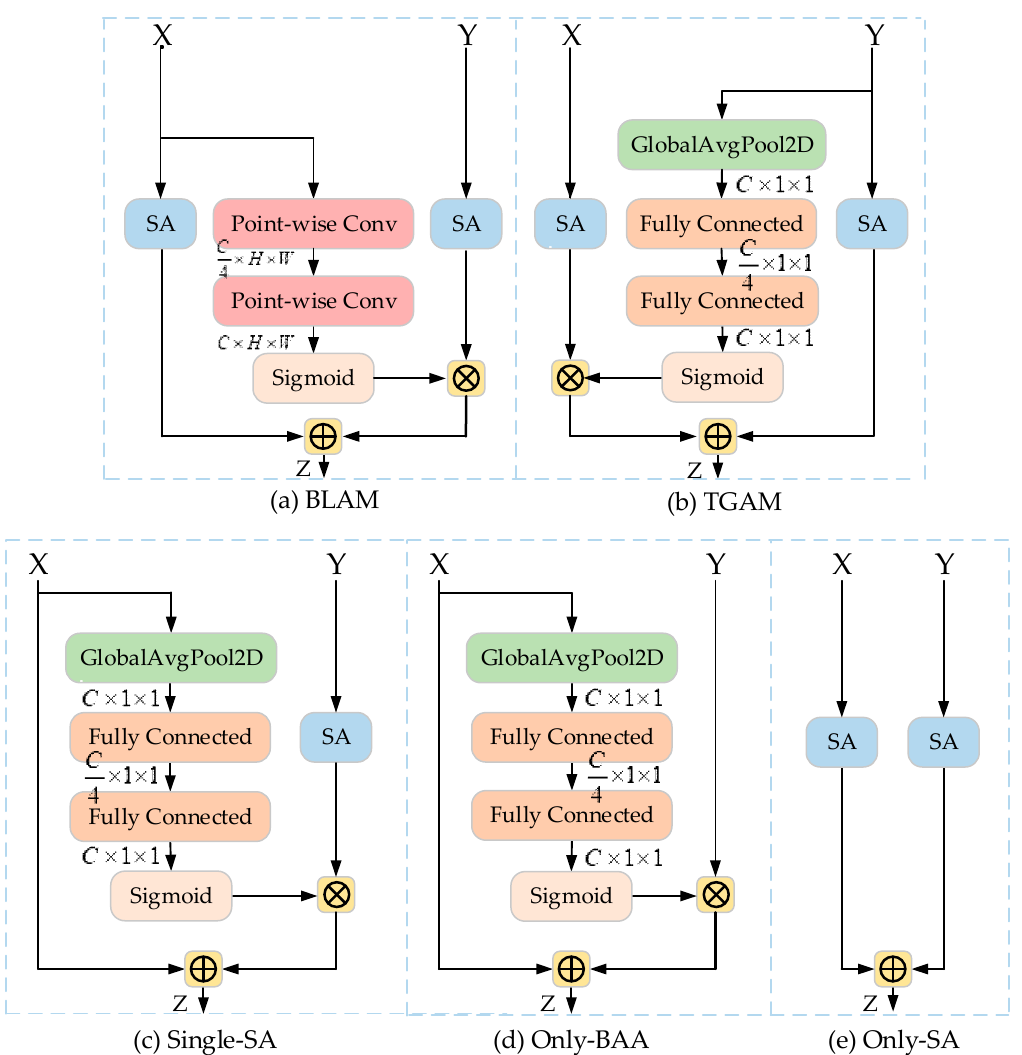
Figure 8. Architectures used in the ablation study on modulation scheme. ( a ) Bottom-up modulation with point-wise channel attention module (BLAM). ( b ) Top-down modulation with global channel attention module (TGAM). ( c ) Bottom-up modulation with single-SA attention module (single-SA). ( d ) Only bottom-up modulation module (only-BAA). ( e ) Only SA block modulation (only-SA). All architectures shared the same hyperparameters.